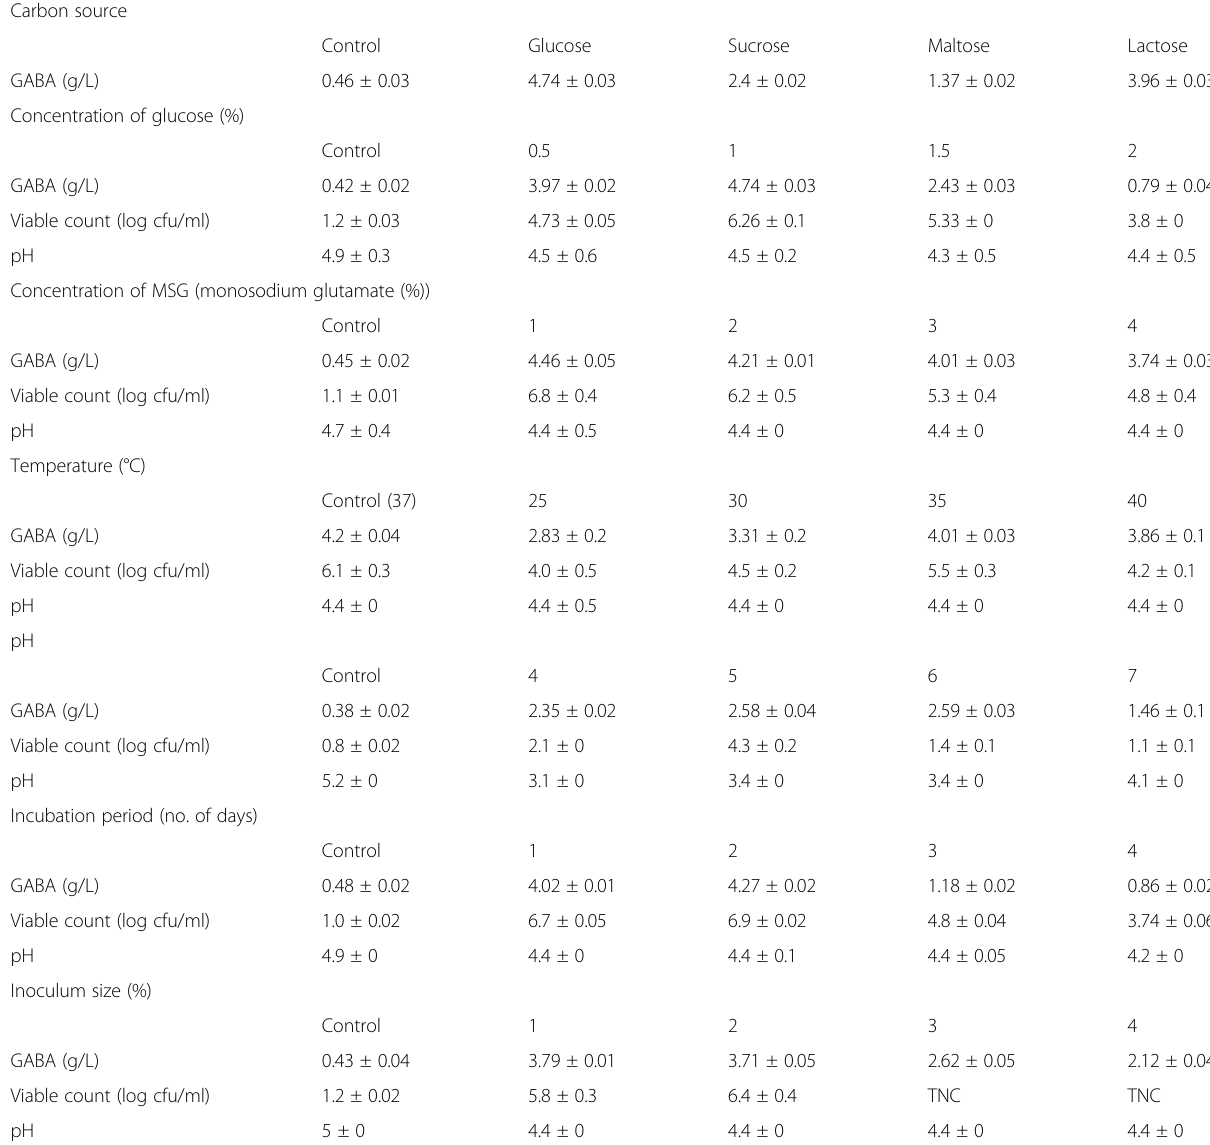
Table 3 Effect of physical and nutritional parameters on GABA production by Lb. fermentum in soymilk: carbon source, MSG concentration, temperature, pH, incubation period, inoculum